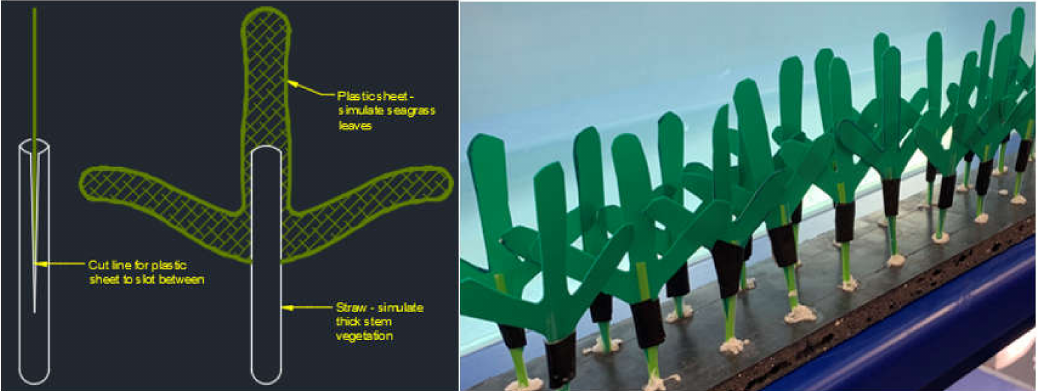
Figure 5. Artificial sea grass